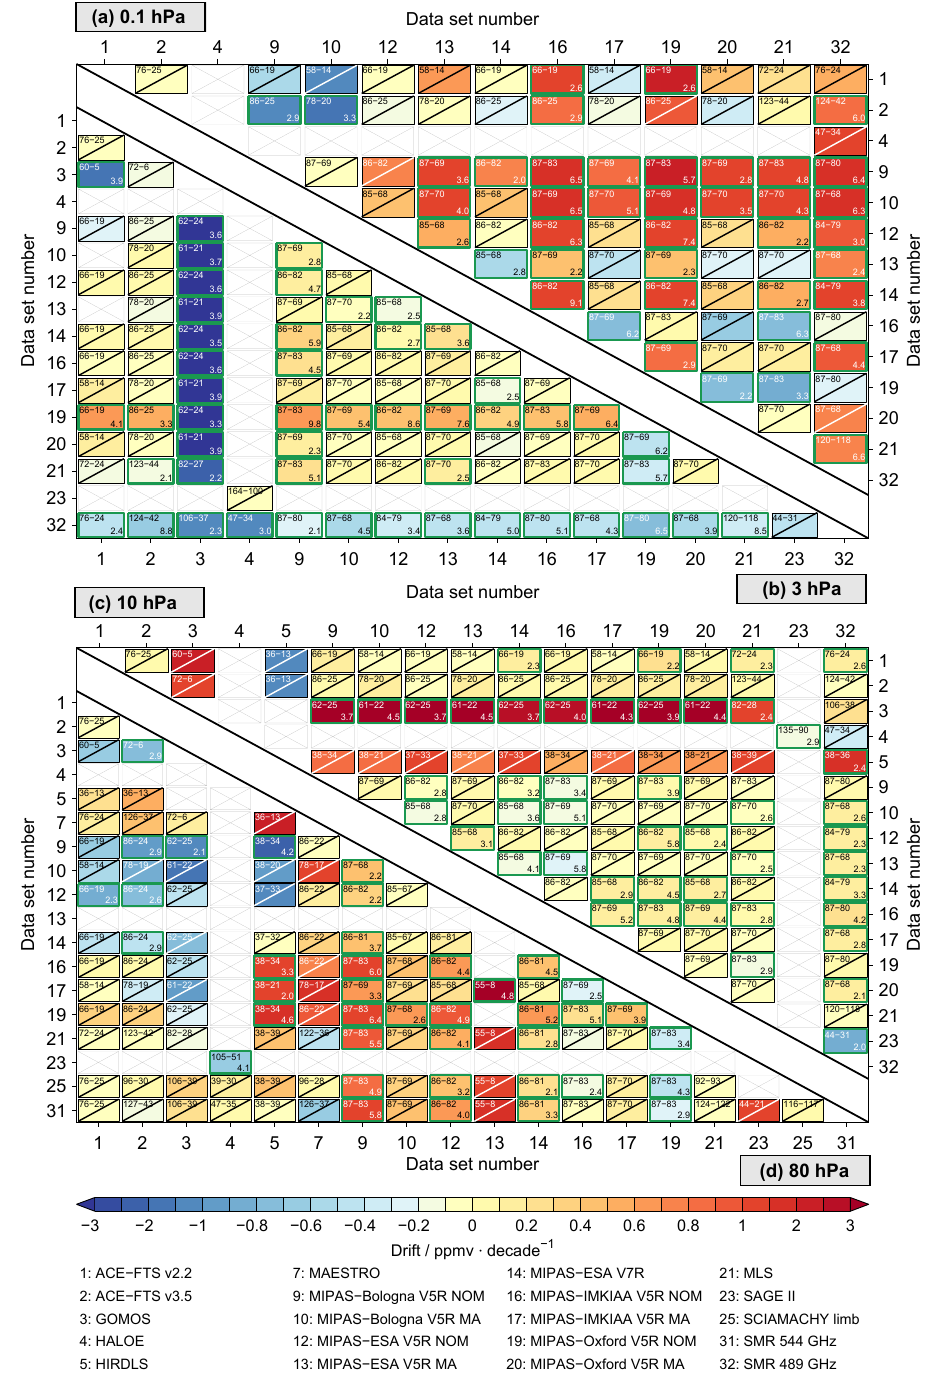
Figure 12. As Fig. 11, but here for the tropics, i.e. between 15 ◦ S and 15 ◦ N.